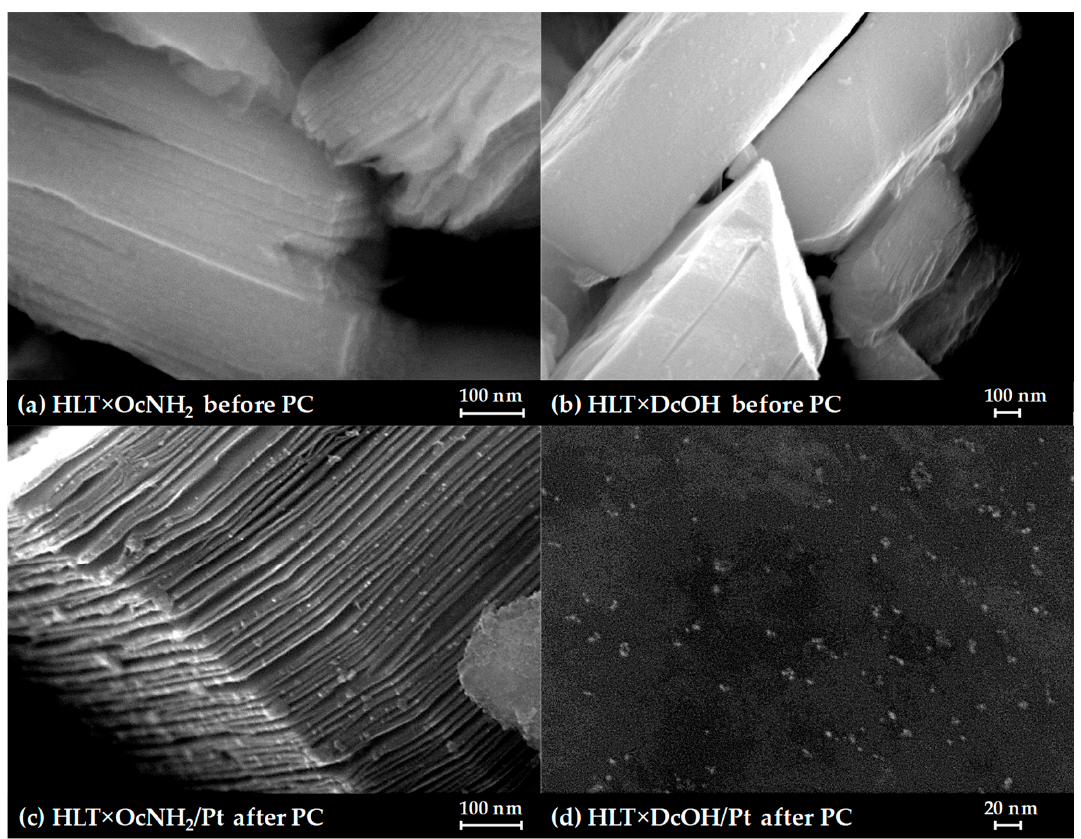
Figure 7. SEM images of the initial n -octylamine ( a ) and n -alkoxy ( b ) derivatives and their composites with a Pt cocatalyst after the photocatalytic experiment ( c , d ).